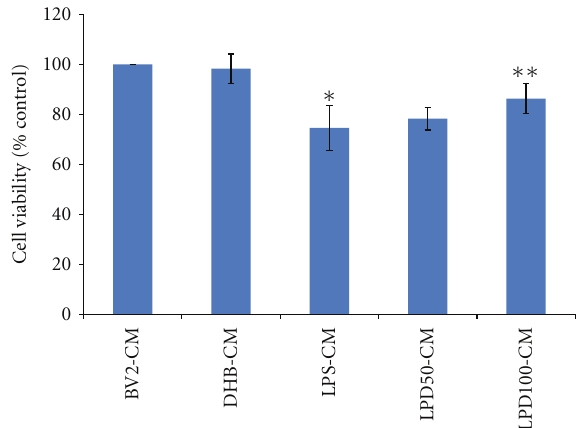
Figure 6: BV2 cells were stimulated with LPS (100ng/mL) ± DHB (100 μ M) for 24 h. CM from control (BV2-CM), DHB treated (DHB-CM), LPS-treated (LPS-CM), and LPS/DHB treated (50 & 100 μ M; LPD50-CM, LDP100-CM) BV2 cells was added to dopaminergic N27 cells plated in 96 well plates. After 48h, N27 cell viability was assessed via the MTT assay. Data is expressed as mean ± SD, n = 4. ∗ P < 0 . 01, compared with control-CM group, ∗∗ P < 0 . 01, compared with LPS-CM